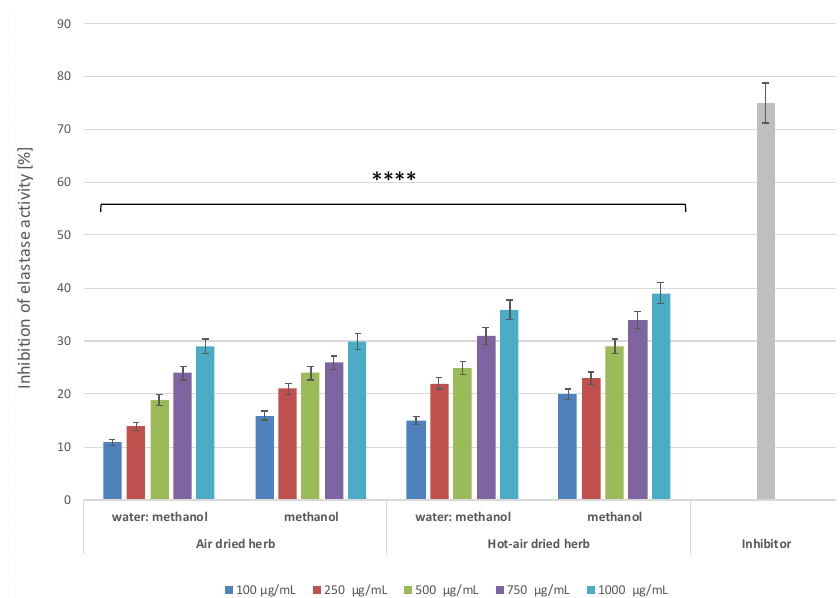
Figure 10. Elastase inhibitory activity of B. officinalis extracts. Data are the means of three independent experiments, each consisting of two replicates per treatment group. **** p < 0.0001 versus the control.